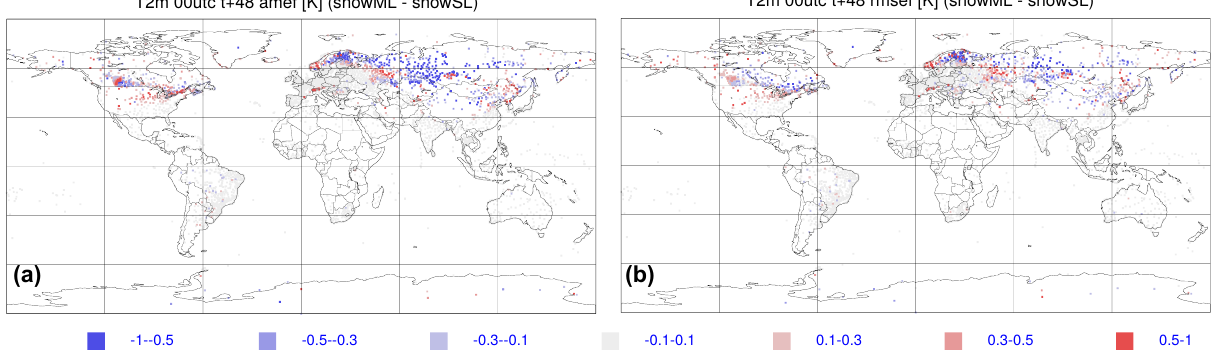
Figure 18. Temperature verification at screen level (T2m). ( a ) Absolute mean error difference (amef) at a lead time of 2 days between coupled forecasts with the multi-layer (snowML) and single-layer (snowSL) snow schemes; ( b ) Same as ( a ), but showing root-mean-square-error difference